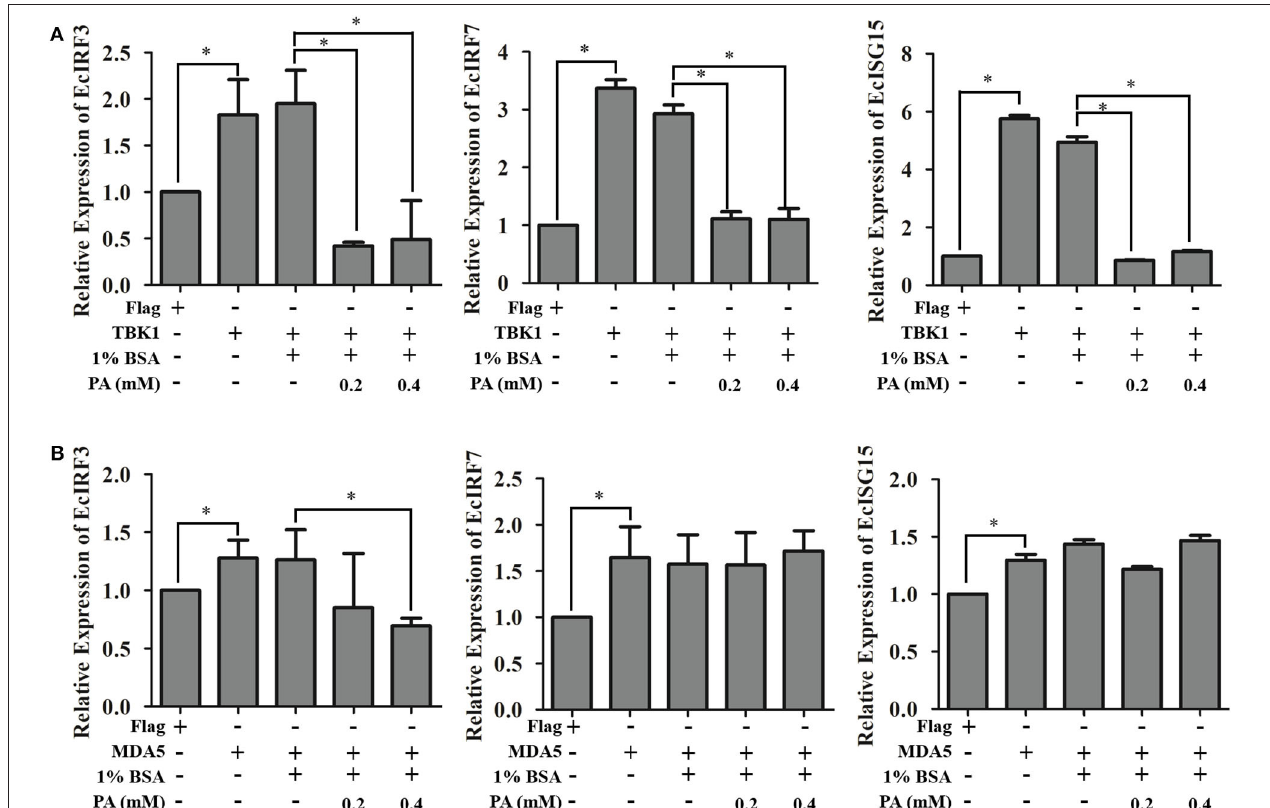
FIGURE 8 | Palmitic acid decreased TBK1-, but not MDA5-induced interferon immune response. GS cells were transfected with EcTBK1 (A) or EcMDA5 (B) and then incubated with 1% BSA or palmitic acid at indicated concentrations (0.2 or 0.4mM). The transcription of interferon related genes, including EcIRF3, EcIRF7, and EcISG15, were detected using qRT-PCR. Setting the mRNA expression level in Flag transfected cells as 1-fold. All data are representative of three independent experiments. The data are represented as mean ± SD, and the statistical significances were determined with Student’s t -test, n = 3. The significance level was defined as * p <